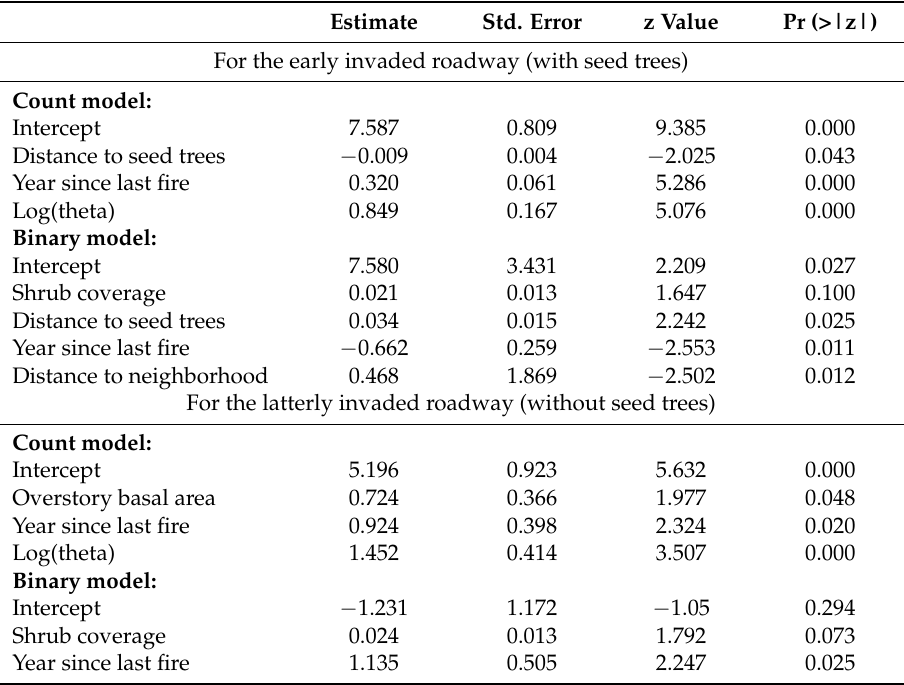
Figure 4. The cumulative increase in density and age structure (inserted) of tallow trees along selected roadways: ( A ) With seed trees; ( B ) without seed trees. Table 1. Estimated coefficients of the ZINB model for the early invaded roadway (with seed trees) and the roadway invaded latterly (without seed